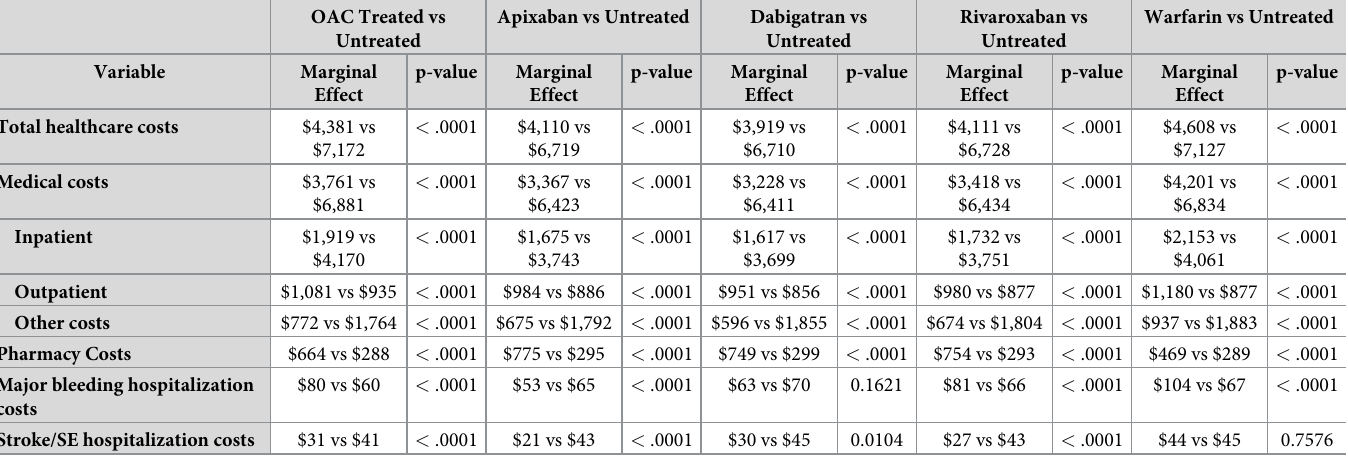
Table 2. Comparison of per patient per month adjusted healthcare costs between OAC treated and untreated patients after first atrial fibrillation diagnosis �